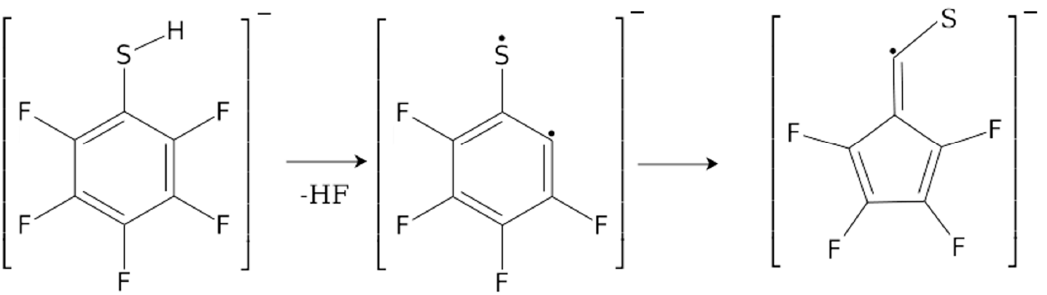
Figure 2. Considered rearrangement of the phenyl ring subsequent to the HF loss upon DEA to PFTP and 2-FTP. In the figure, this is shown for PFTP as an example. In this process, after the HF loss, the 6-membered benzene ring rearranges into a 5-membered ring with